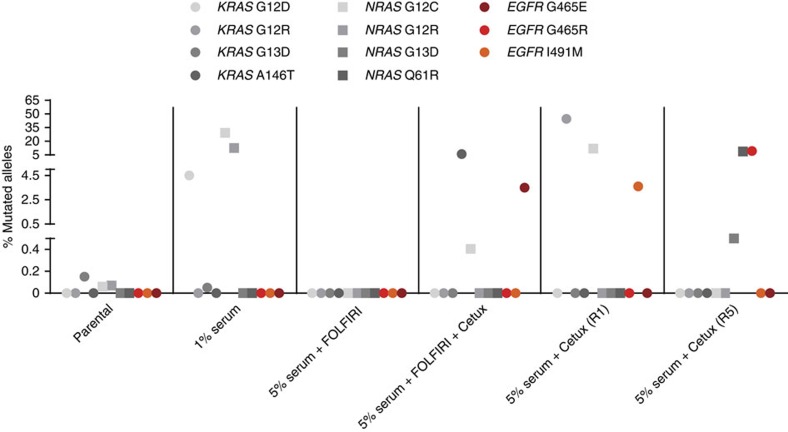
Emergence of RAS and EGFR ECD mutations in CRC cell populations.RAS and EGFR mutation frequencies were measured by ddPCR and are indicated for LIM1215 cells cultured in low-serum, chemotherapy, chemotherapy plus cetuximab and cetuximab-only conditions. R1 and R5 cetux indicate two resistant populations of LIM1215 generated independently. Cetux, cetuximab.